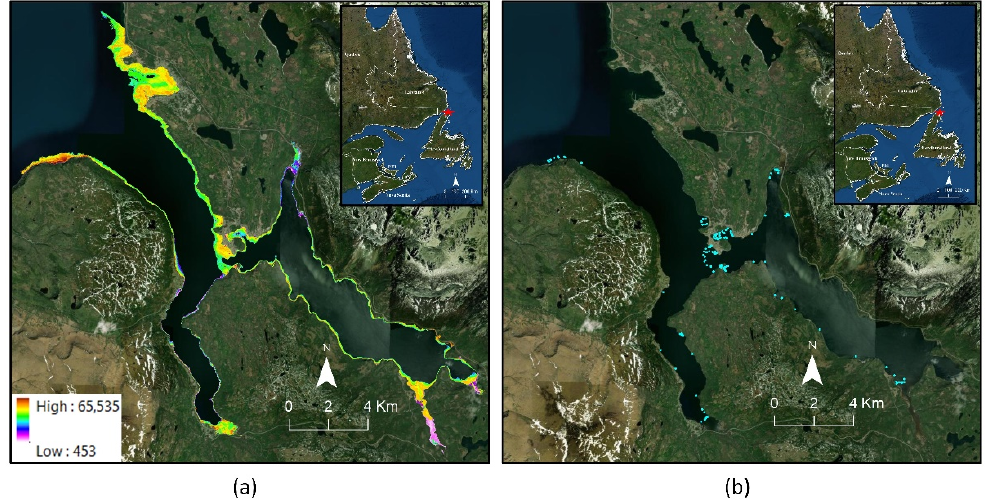
Figure 1. ( a ) Coverage of the LiDAR data (the image shows the intensity values), ( b ) distribution of the in situ samples over the study area. The red star indicates the location of the study area (i.e., Bonne Bay in Newfoundland, Canada).